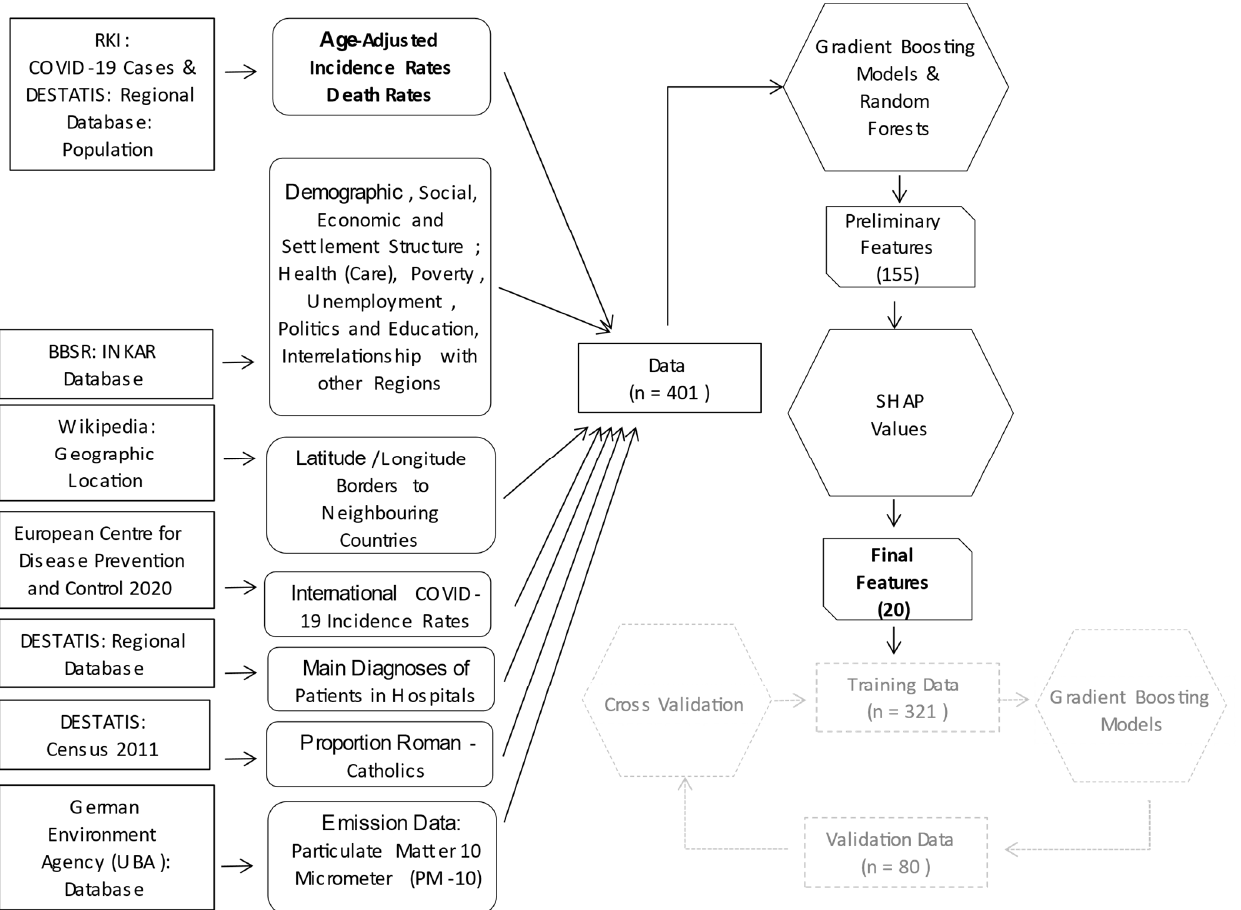
Figure 1. Analysis strategy.